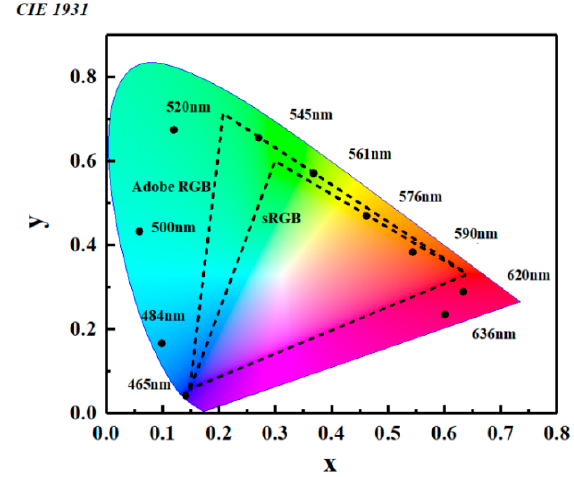
Figure 8. The chromaticities of transmissive spectra at different wavelengths. The two triangles stand for the gamut scale of Adobe RGB and sRGB.